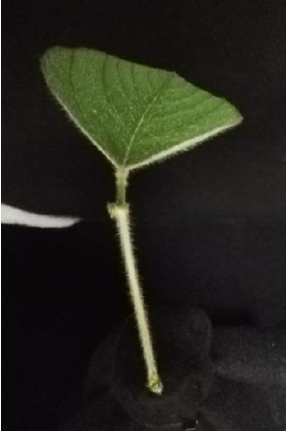
Sensors 2018 , 18 , x FOR PEER REVIEW Figure 7. The sample soybean leaf attached to the base platform covered by a sheet of black cloth.